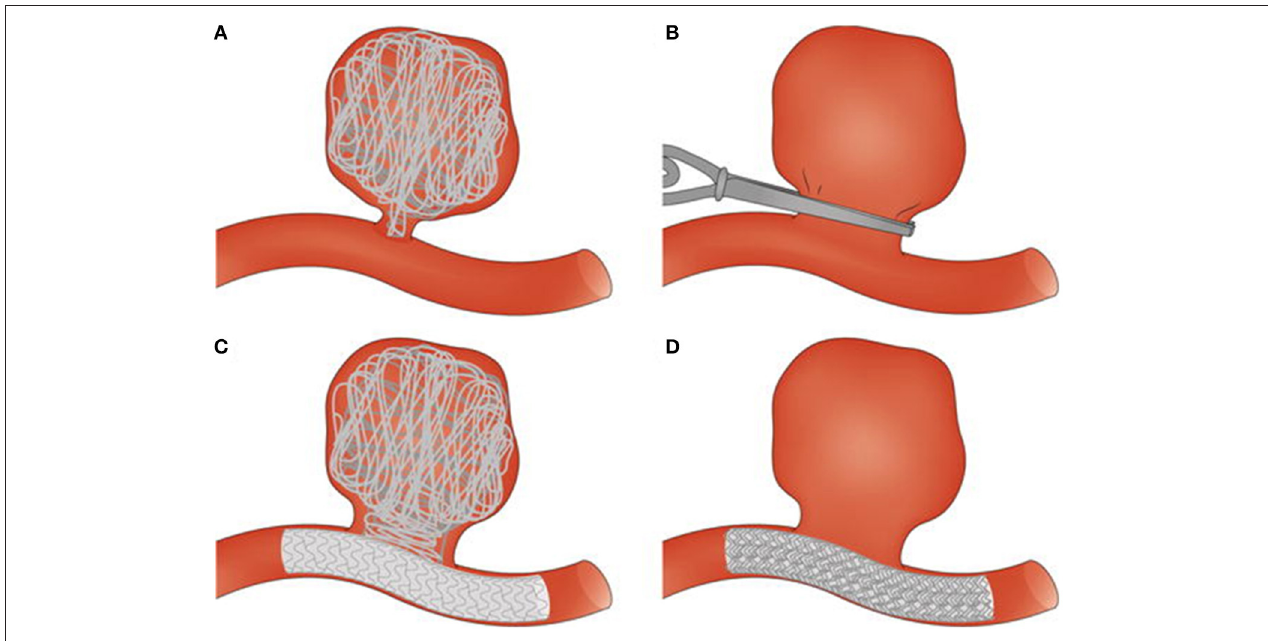
FIGURE 1 | Surgical and endovascular treatments for cerebral aneurysm thrombosis. (A) Endovascular coiling of the aneurysm sac. (B) Surgical clipping of the aneurysm neck. (C) Endovascular treatment combining use of coils and a stent. (D) Endovascular treatment with a flow diverter. Taken from Perrone et al.